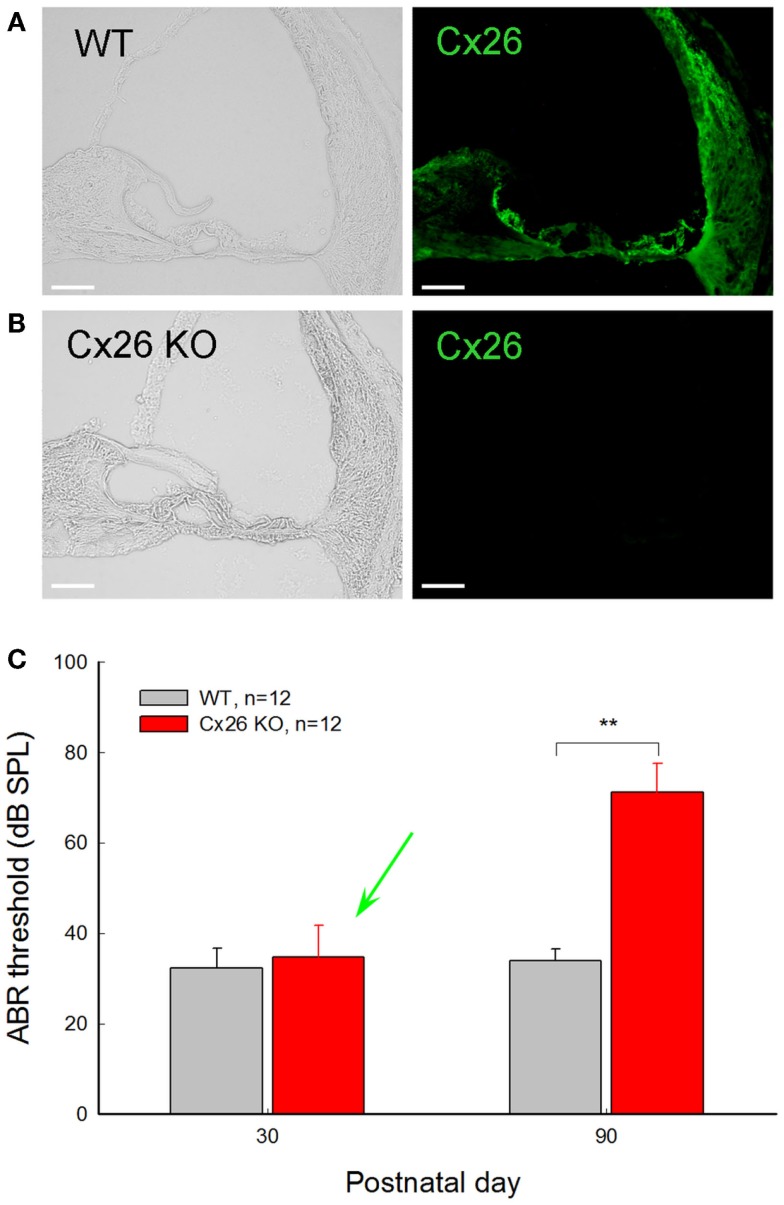
Normal hearing in young Cx26 KO mice after deletion of Cx26 after birth. (A,B) Immunofluorescent staining for Cx26 in the cochlea in WT and Cx26 KO mice at P30 following deletion of Cx26 at P10. No positive labeling is visible in the Cx26 KO mouse. (C) ABR thresholds of WT and Cx26 KO mice were measured at P30 and P90 following deletion of Cx26 at P10. A green arrow indicates that the ABR threshold in Cx26 KO mice at P30 remained normal, even though the expression of Cx26 in the cochlea was already deleted [see (B)]. At P90, Cx26 KO mice had a significant increase in ABR threshold, displaying hearing loss. **, P < 0.001, t-test. Scale bars: 50 μm. Modified from Zhu et al. (2015).